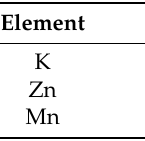
Table 3. KOH solution